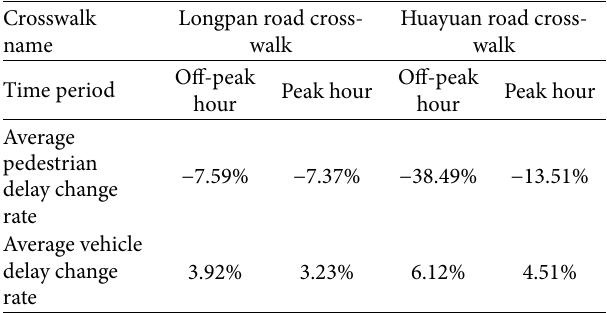
Table 3: The average delay change rates for each crosswalk under each